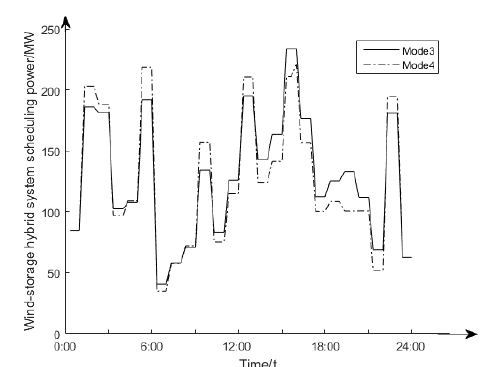
Figure 5. The actual output of the wind–storage–EVs hybrid system in two modes.